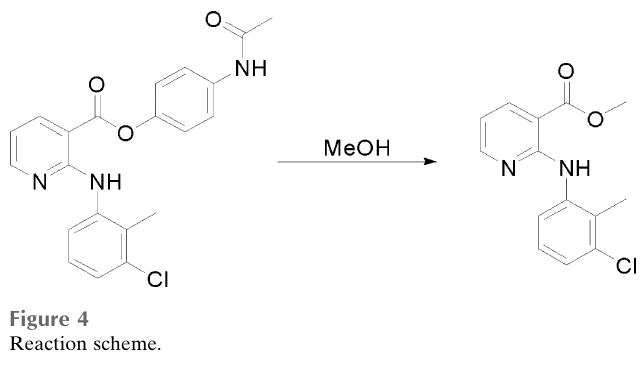
Figure 4 Reaction